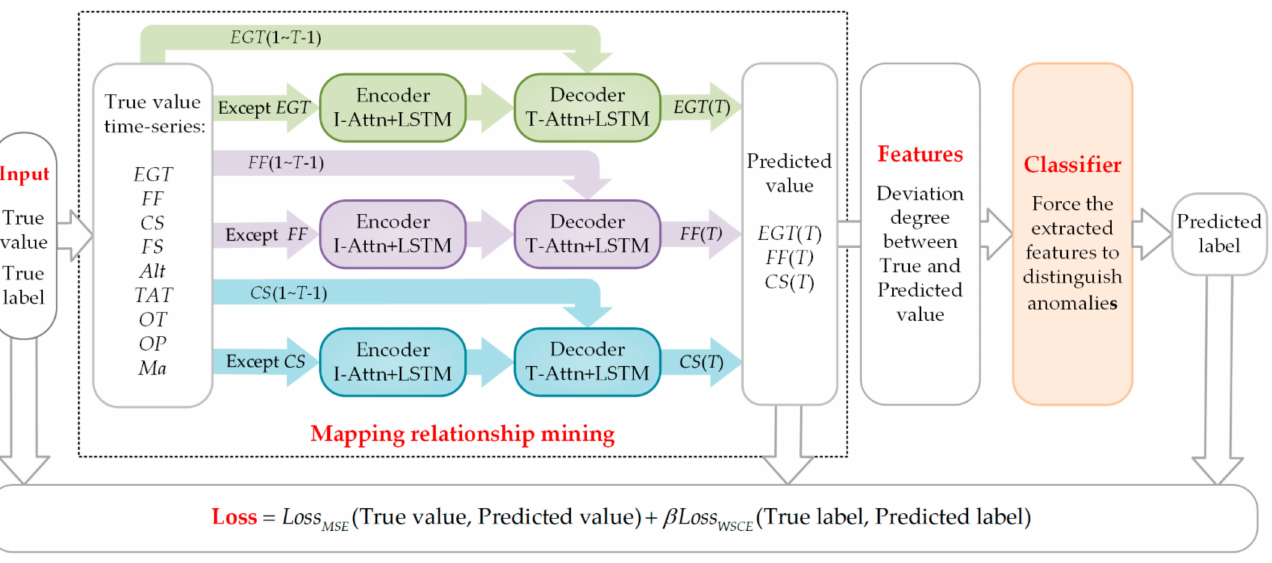
Figure 2. Mapping relation mining-based weakly supervised gas-path feature extraction (WSFE)